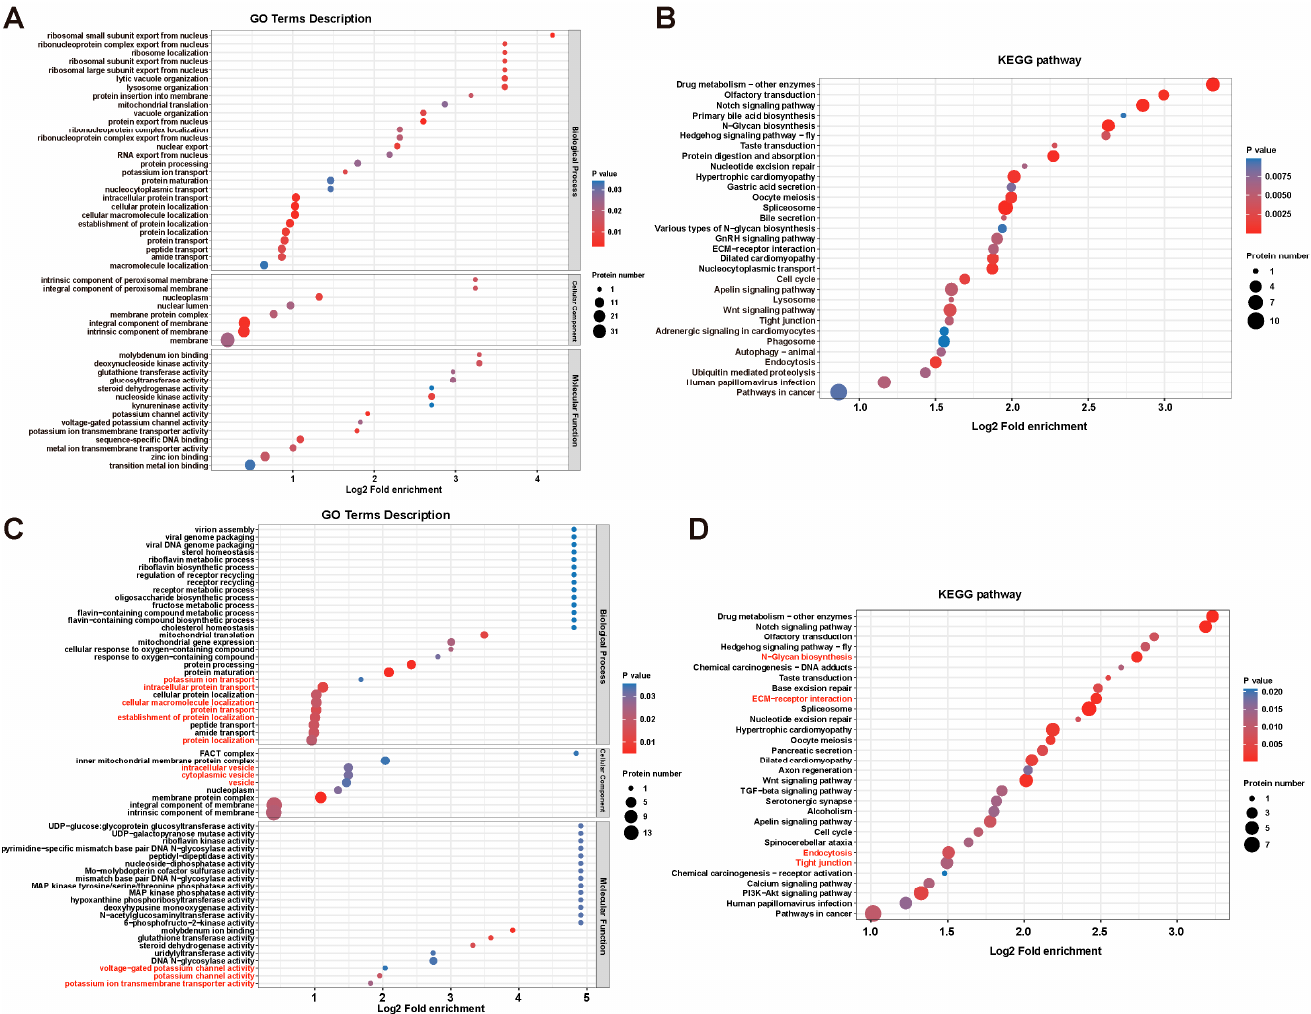
Figure 3. Identification and analysis of DPPs specifically expressed in notochord tissue. ( A ) GO enrichment analysis of the DPPs in notochord. ( B ) KEGG pathway enrichment analysis of the DPPs in notochord. ( C ) GO enrichment analysis of the notochord-specific phosphoproteins with significant downregulated phosphorylation level. ( D ) KEGG pathway enrichment analysis of the downregulated phosphoproteins in notochord. The main enriched items involved in lumenogenesis are highlighted in red.